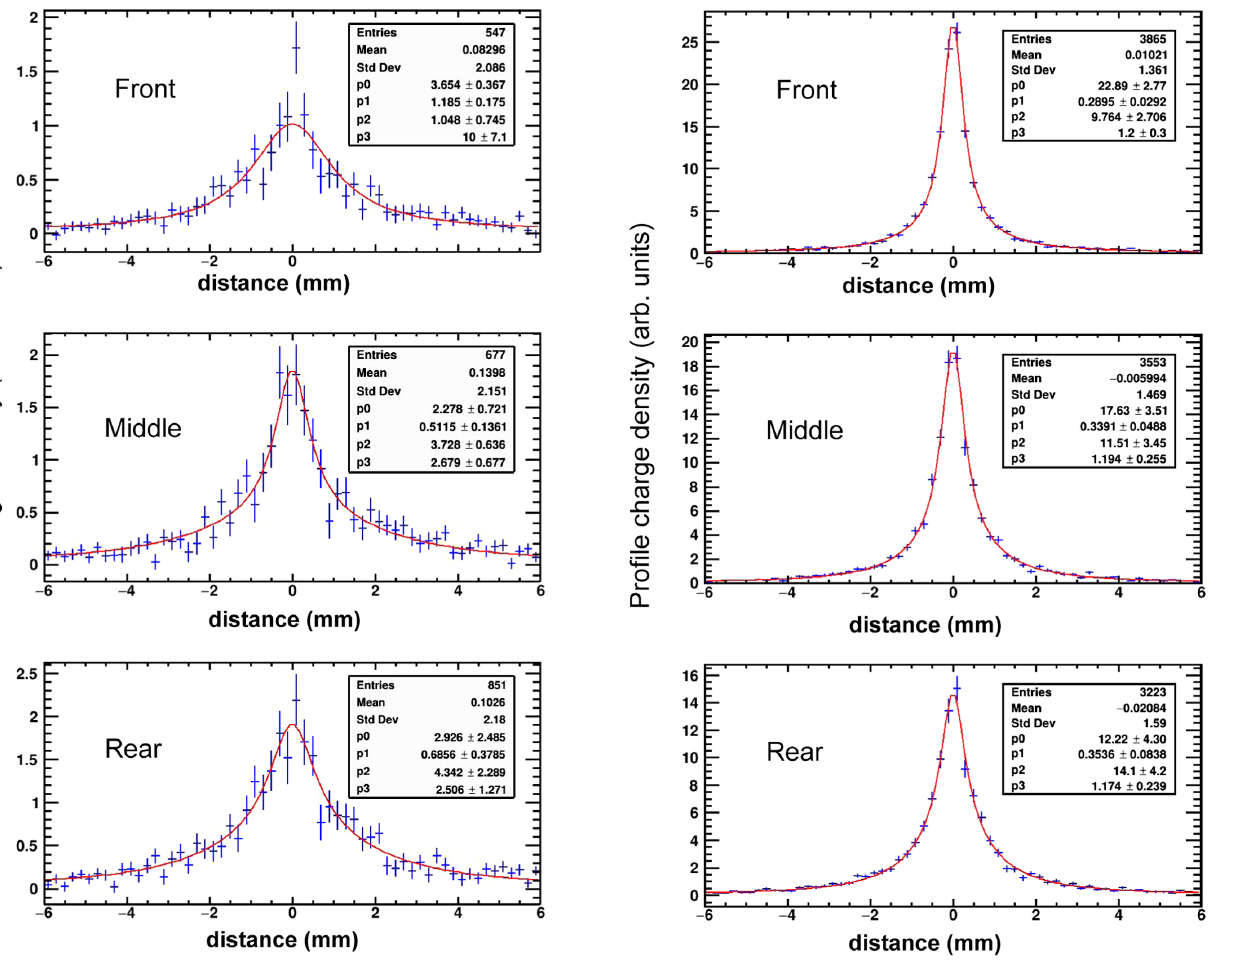
FIG. 4. Similar to Fig. 3, but now without any gaps between the preshower tungsten block and detector